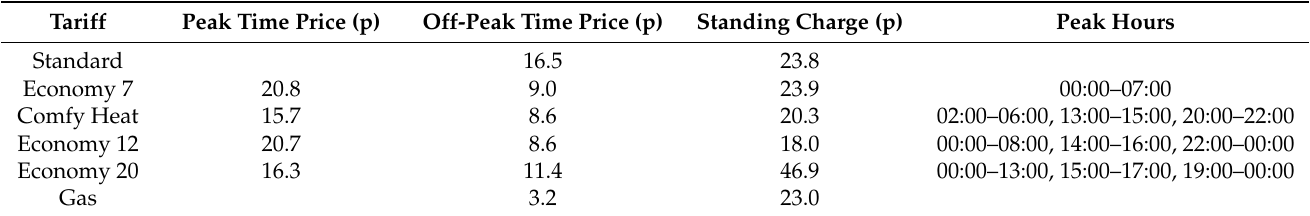
Table A1. Electricity and gas tariffs, and distribution of peak hours during the day